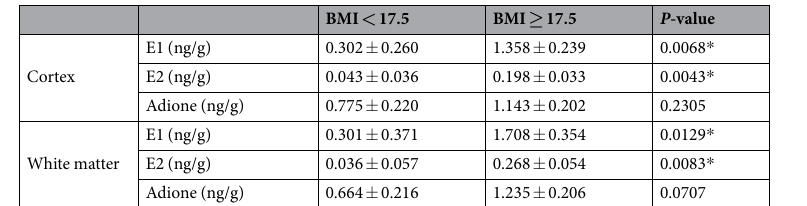
Table 3. Comparison of concentrations of sex steroid hormones in the cortex and white matter of the frontal lobe between subjects with body mass index < 17.5 and ≥ 17.5. * Significant; P < 0.05/3 (Bonferroni adjustment). BMI, body mass index; E1, estrone; E2, estradiol; Adione, androstenedione.